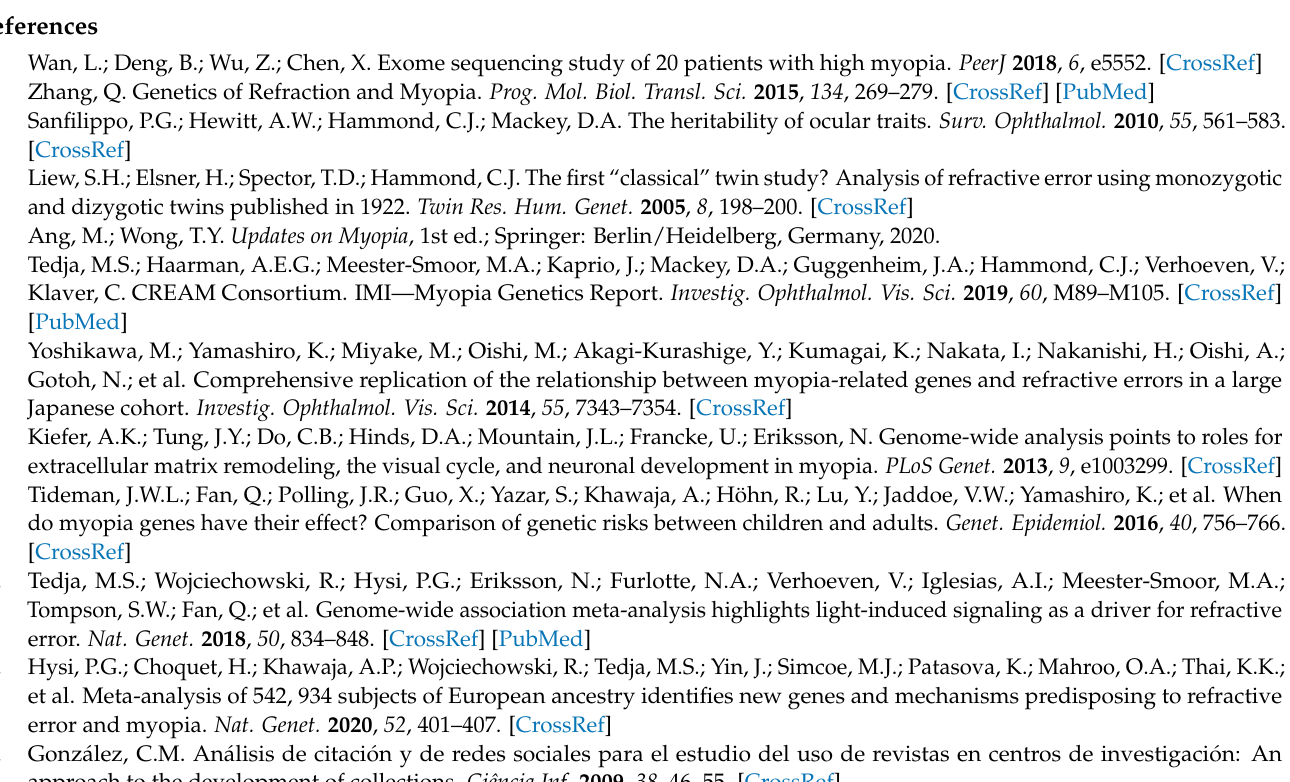
Table S1: Characteristics of the main countries; Table S2: Characteristics of the main authors; Table S3: Characteristics of the main institutions; Table S4: Characteristics of the main